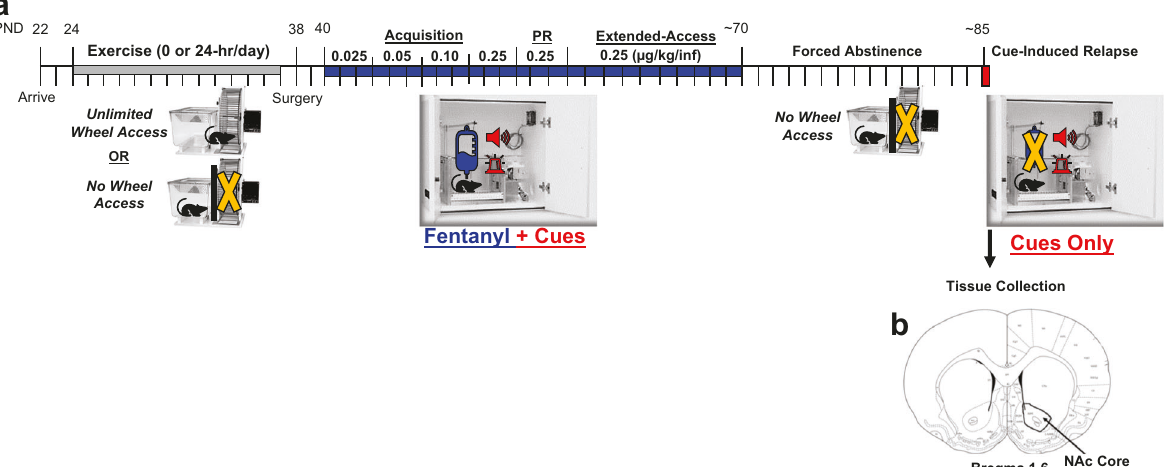
Fig. 1 Experimental timeline. a Rats arrived on postnatal-day (PND) 22 and were given high-access exercise (24-hr/day) or no wheel access for 2-weeks (PND 24 – 37). Following recovery from catheterization surgery, rats underwent acquisition testing under an escalating dose procedure (0.025, 0.05, 0.1, 0.25 µg/kg/infusion, 3 days/dose; ~PND 40 – 51). PR testing for fentanyl (0.25 µg/kg/infusion) began after the fi nal acquisition test session (~PND52). Rats were then given extended, 24 h/day, access to fentanyl for 10 days using an intermittent-access procedure ( fi xed-ratio 1, 5 min trials every 30 min; PND ~58 – 68). Vulnerability to relapse was assessed following a 14-day abstinence period using a within-session extinction/cue-induced reinstatement procedure. Gray and blue bars show periods of exercise and fentanyl availability, respectively. b Tissue was dissected from the core region of the nucleus accumbens (NAc) the day following the relapse test